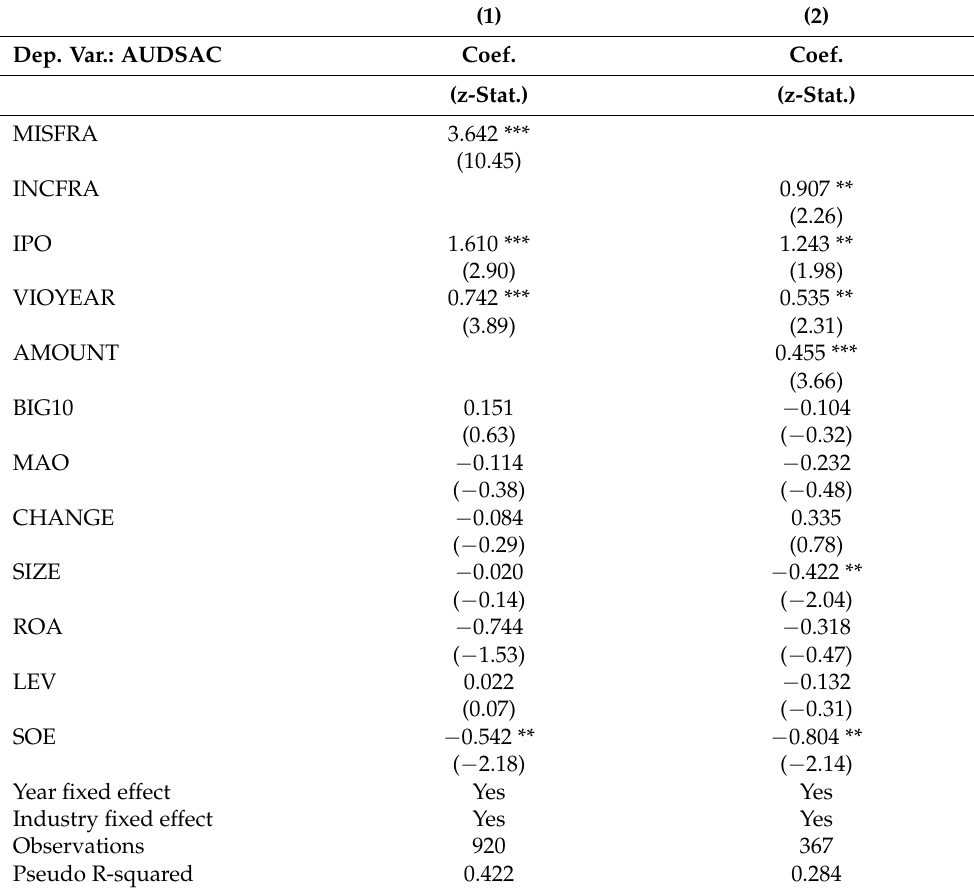
Table 4. Regression results of Model (1) and